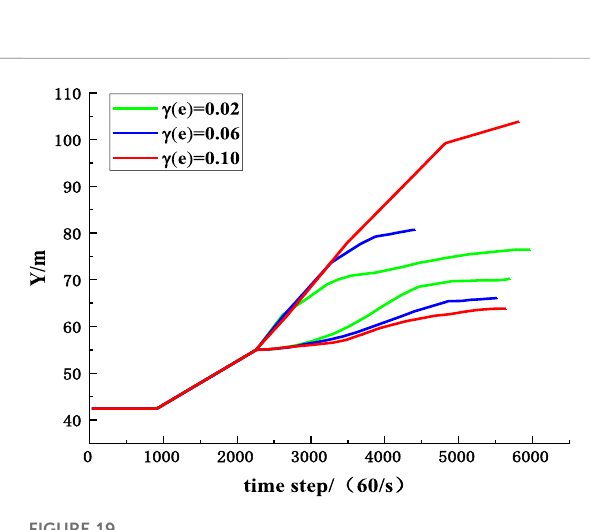
FIGURE 19 The in fl uence of randomness of collision recovery coef fi cient on lateral position coordinates of rockfall.